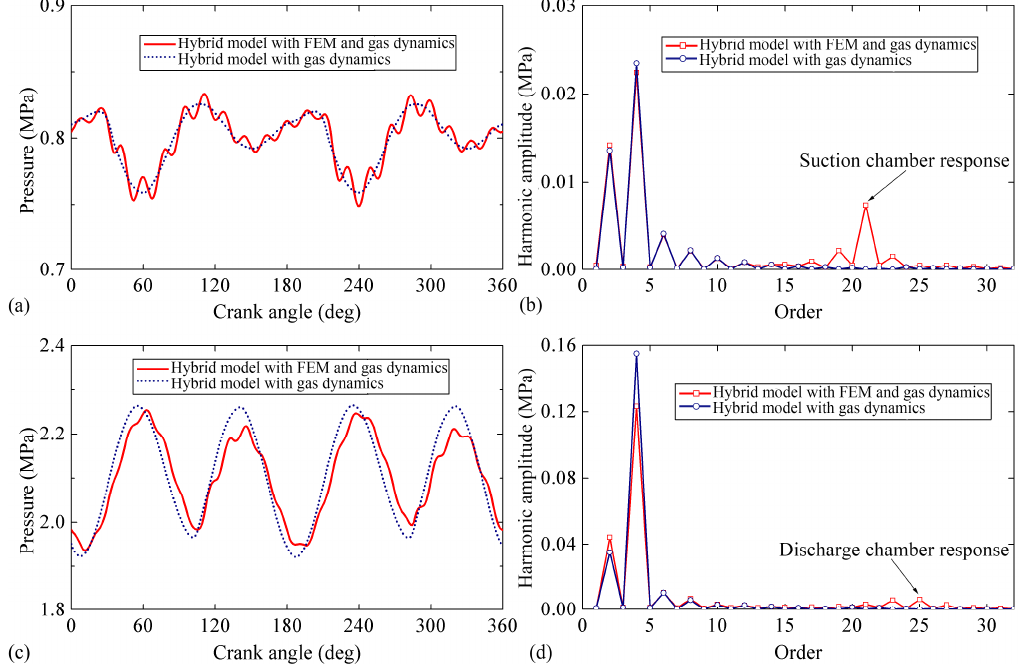
Figure 7. Comparison of: ( a ) pressure profile and ( b ) amplitude-frequency characteristics at the suction pipe-end; ( c ) pressure profile and ( d ) the amplitude-frequency characteristics at the discharge pipe-end.